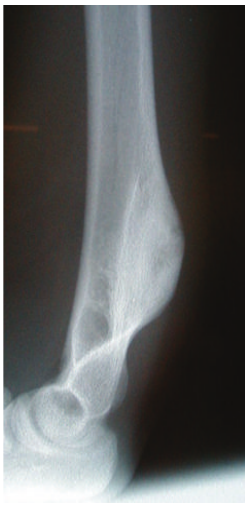
Figure 1: Lateral X-ray of the distal right humerus showing a dense bony protuberance arising from the distal aspect of the humerus on the posterior surface without periosteal